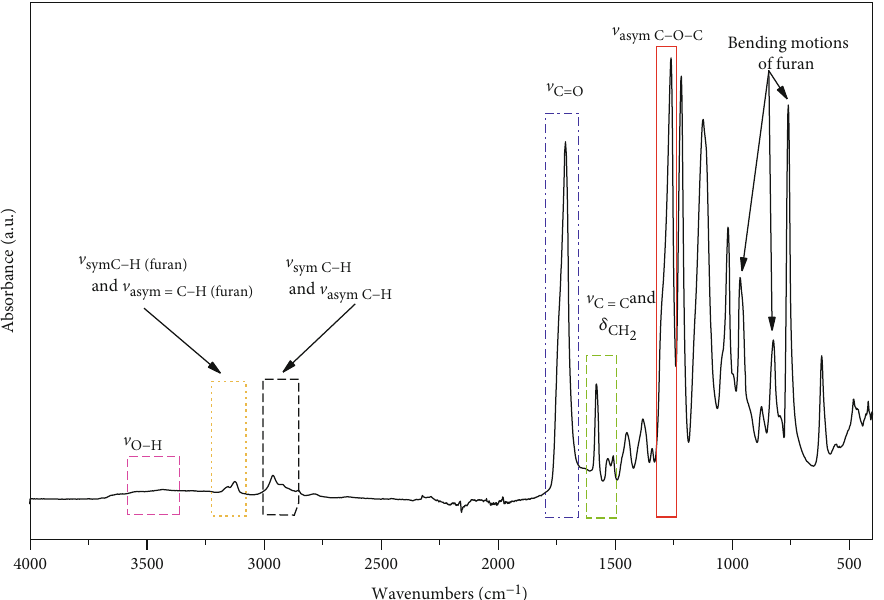
Figure 2: FT-IR spectrum of a copolymer synthesized with feed ratio of MEG : BD = 5 : 5 .